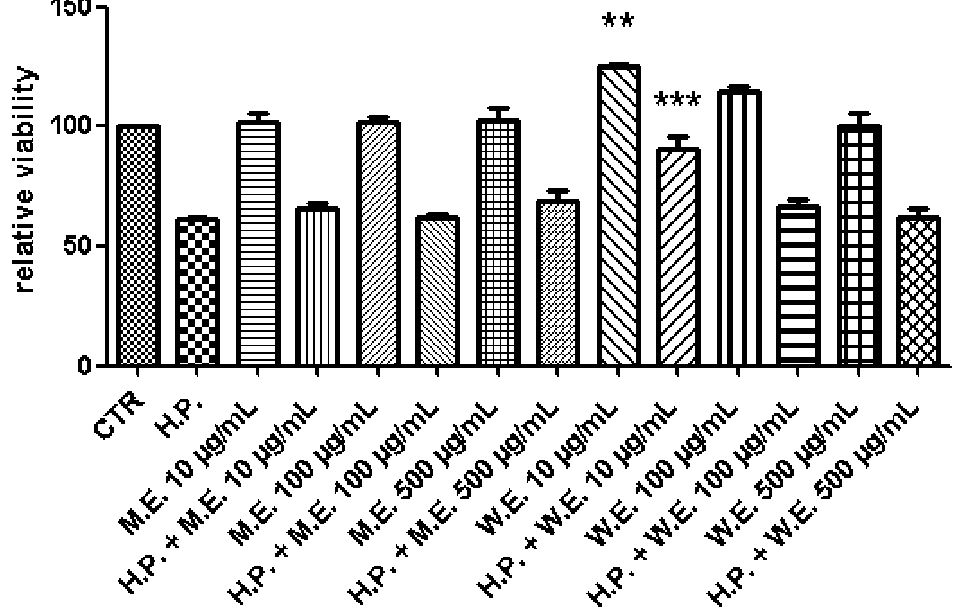
Figure 3. Effects of P. foetida methanol (M.E.) and water (W.E.) extracts on basal and hydrogen peroxide 300 μ M (H.P.)-induced hypothalamic HypoE22 cell viability (MTT test). Cell viability was